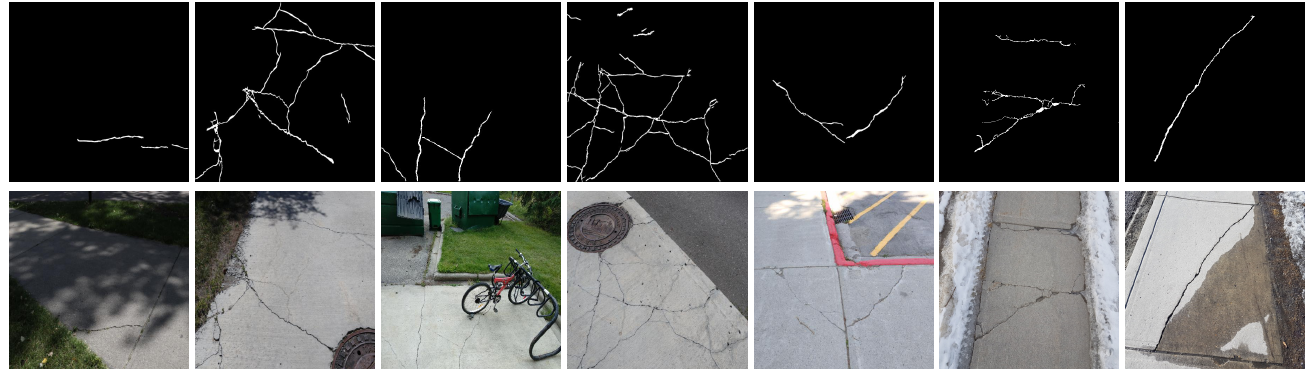
Figure 2. Samples of the collected dataset (CCSS-DATA)—First Row: Ground truth of cracks; Second Row: Corresponding RGB